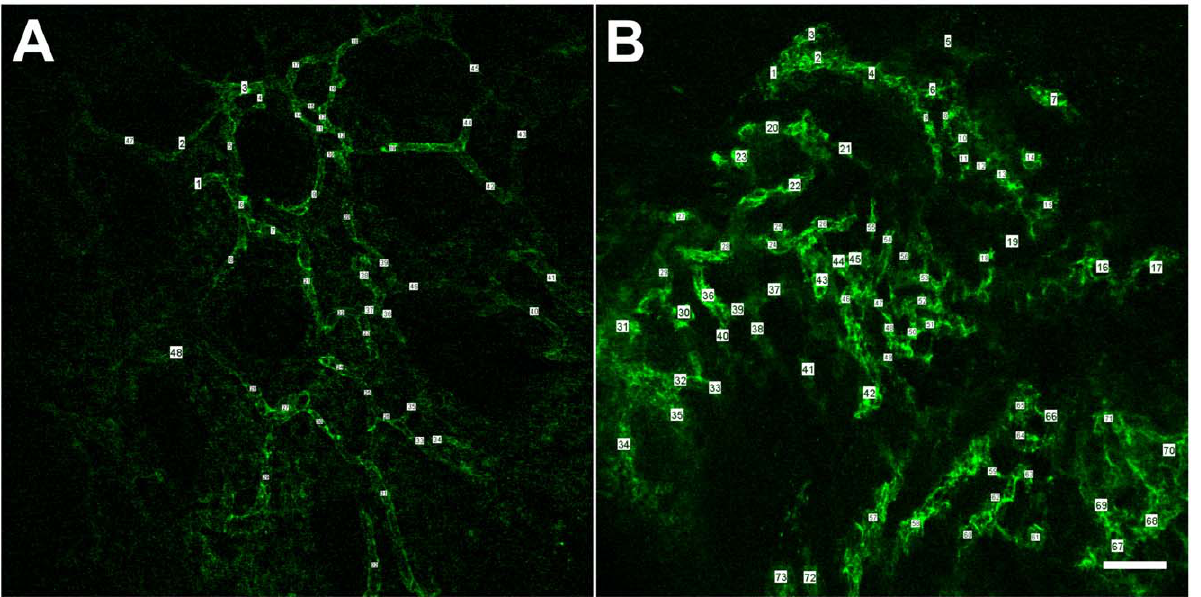
Figure 2. Vascular measurements on CLE images. A vessel was counted and its diameter was measured for each vascular segment between two branching points or a branching point and a loose end. Vascular density was reported per mm 2 . Both vessel diameter and vascular density were increased in the tumor tissue (B) compared to the normal mucosa (A). *Scale bar is 50 m m.